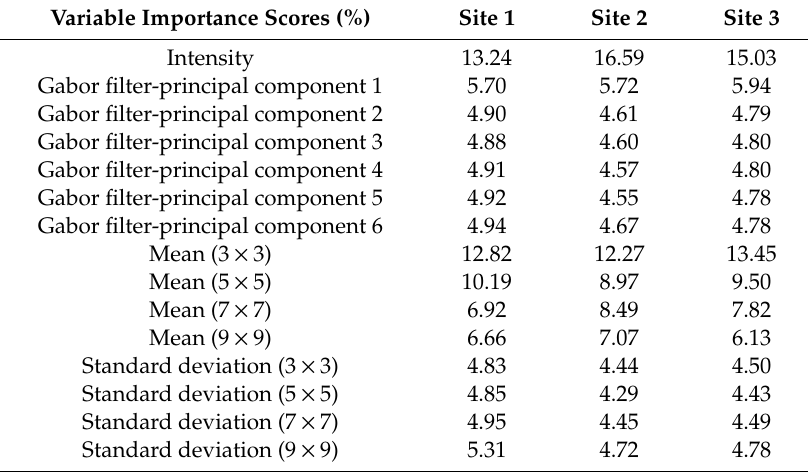
Table 4. Variable importance scores averaged across all classes.